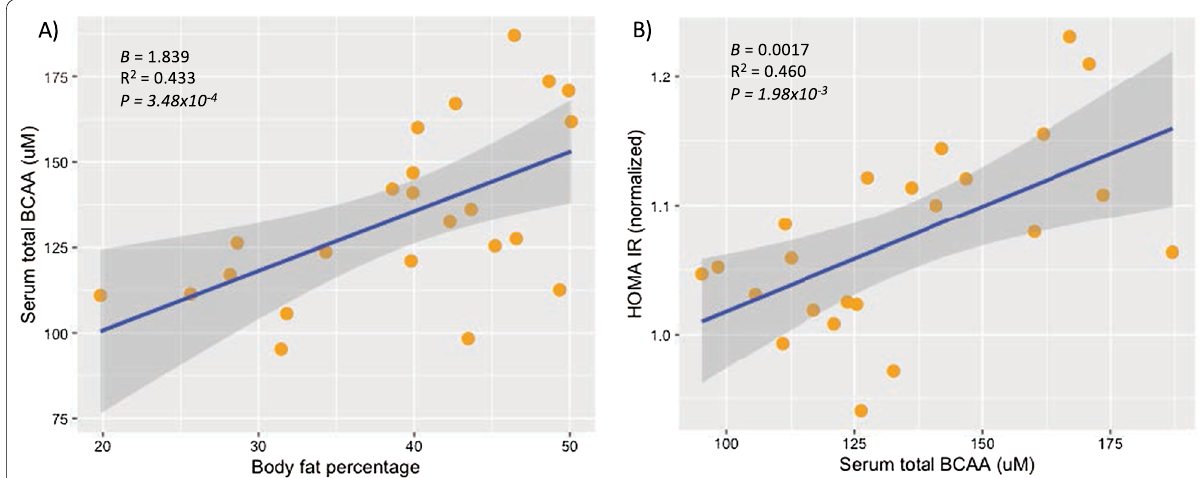
Fig. 1 Association of total BCAA serum levels with the metabolic traits. A multiple linear regression models for the association between body fat percentage and serum levels of BCAA, adjusted for sex and age. B multiple linear regression models for the association between serum levels of BCAA and normalized values of HOMA IR, adjusted for sex and age